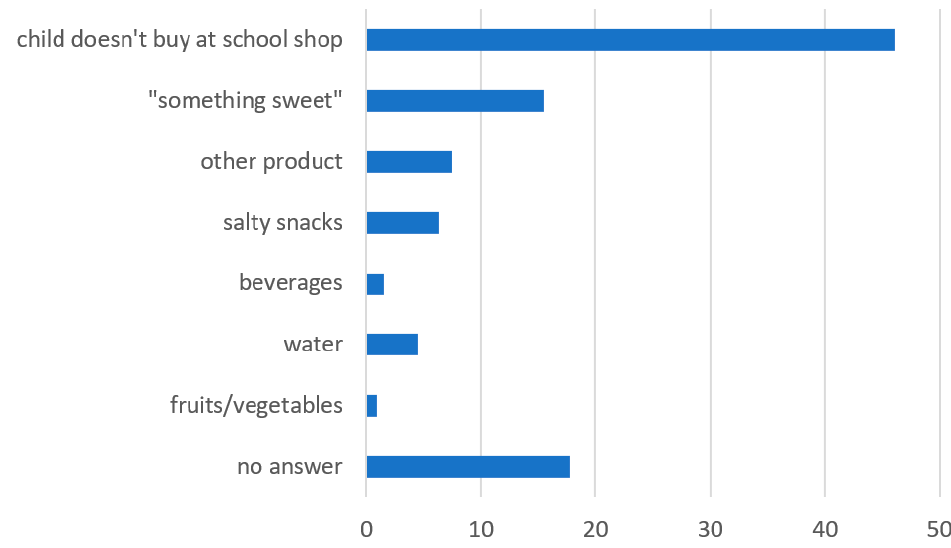
Figure 1. Products most willingly purchased by children from the school shop.